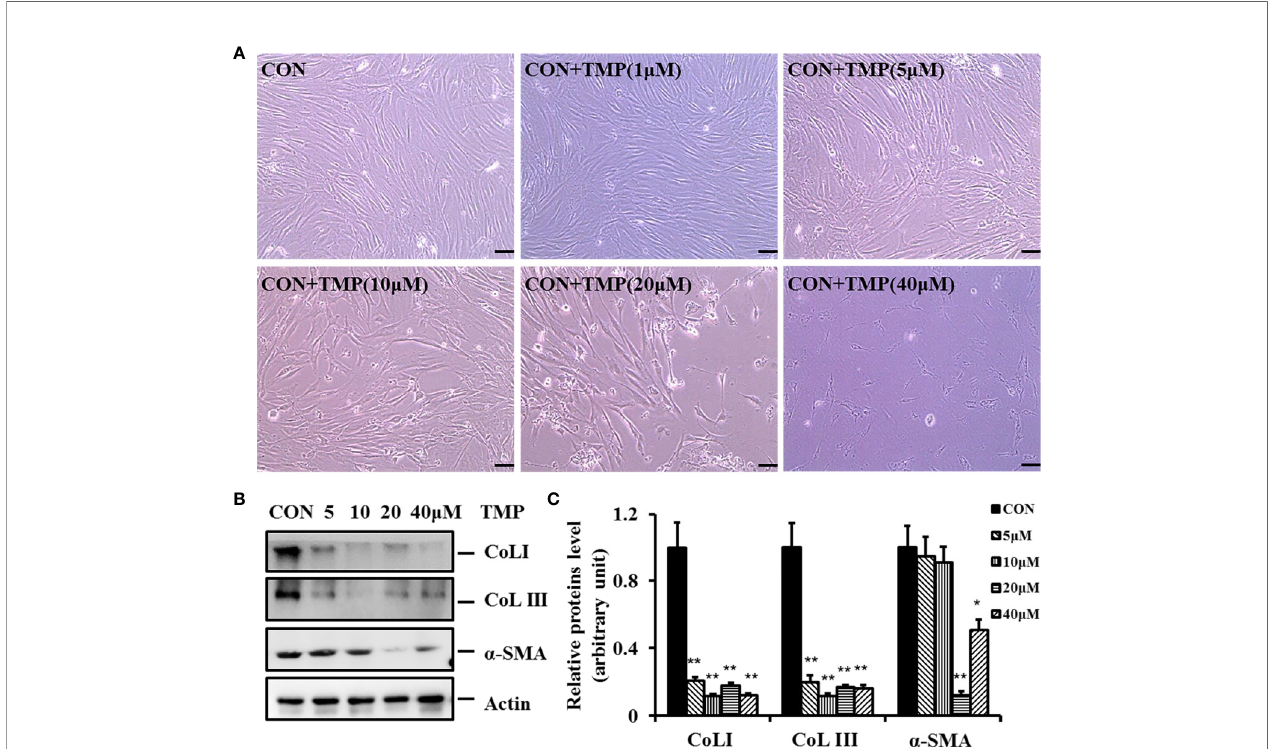
FIGURE 2 | TMP inhibits the protein expression of Col I, Col III, and a -SMA in HFs. (A) Morphologies of HFs were visualized after different concentrations of TMP (0, 1, 5, 10, 20, and 40 µM) under light microscope. (B) HFs treated with different concentrations of TMP were starved for 12 – 16 h in serum-free DMEM, harvested after 48 h, and subjected to western blot analysis. (C) Histogram of the results. All values were normalized to either the negative control. Error bars represented means ± SD of n = 4. * p < 0.05 and ** p < 0.01 vs. control